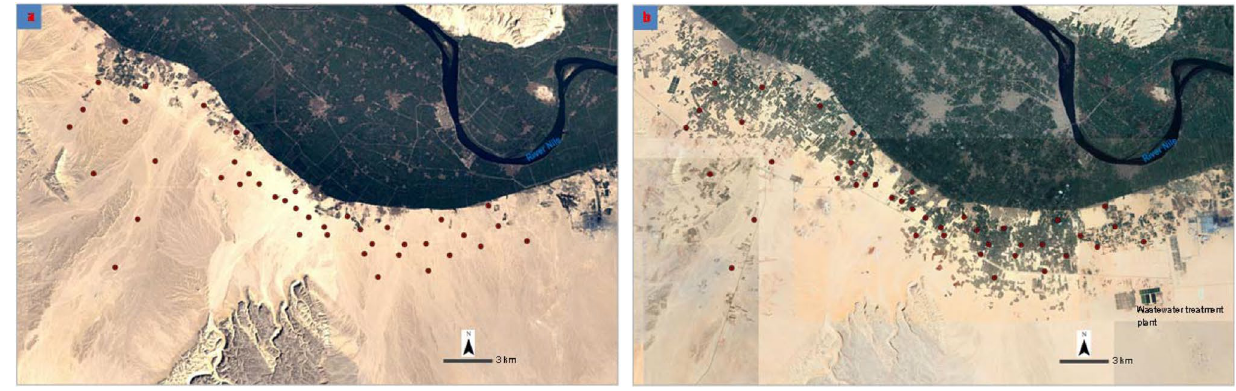
Fig. 2 Map showing the vast changes in the land cover in the study area over a period from 1985 ( a ) to 2020 ( b ). Source of the maps are Google Earth free